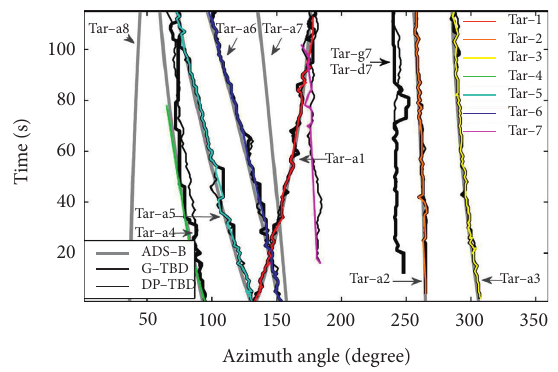
Figure 18: TBD result of time-azimuth traces.